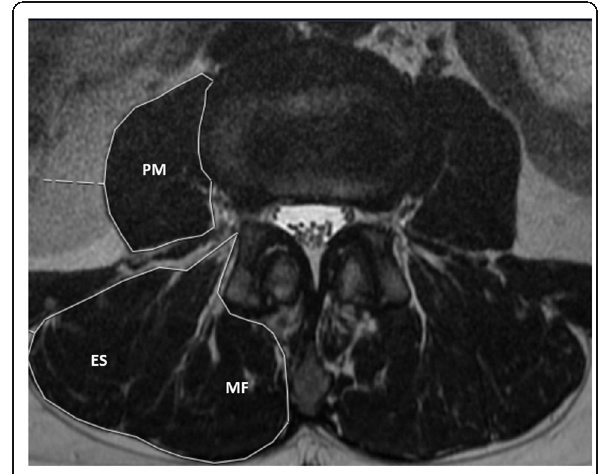
Fig. 2 Axial T2-weighted magnetic resonance image obtained at the level of the upper endplate of L3. The muscle fat index (MFI) was calculated by dividing the mean signal intensity of the psoas major (PM) with the mean signal intensity of the erector spinae (ES) and the multifidus (MF)